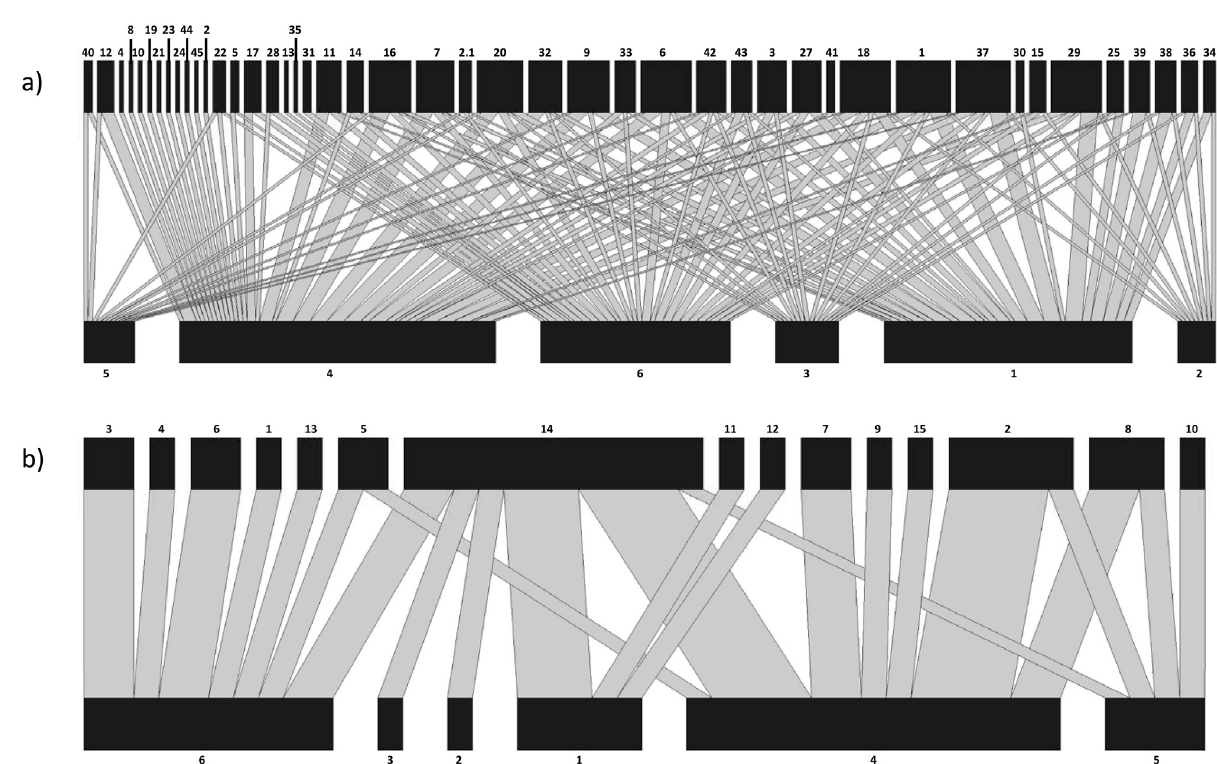
Fig 4. Plant-pollinator networks based on ITS2 and rbcL metabarcoding data using liberal and conservative thresholds. (a) Metabarcoding data filtered using the liberal threshold. (b) Metabarcoding data filtered using the conservative threshold. In each network, the top row represents plant taxa and the bottom row represents bee species. The thickness of the lines represents the frequency of the interactions. A complete list of bee species can be found in the table in S5 Table. A complete list of plant species in Fig 4a and 4b can be found in the tables in S6 and S7 Tables, respectively.